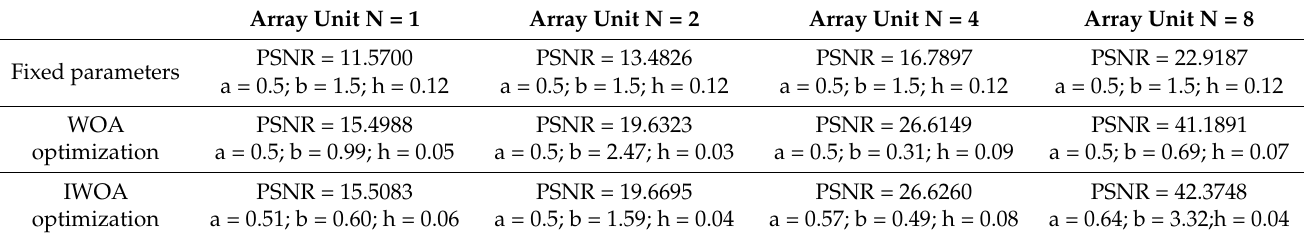
Table 6. MRI image PSNR under different array saturation model methods